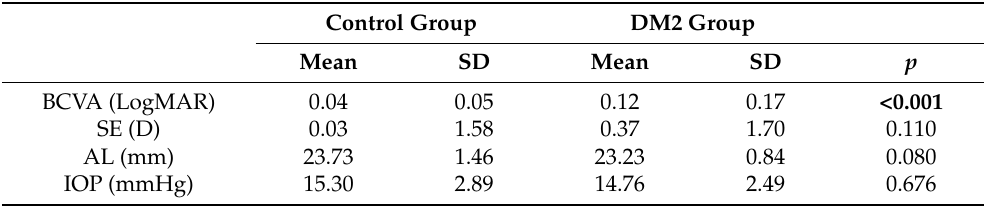
Table 2. Mean, standard deviation (SD), and statistical significance ( p -value) of best corrected visual acuity (BCVA) in the LogMAR scale, spherical equivalent (SE) in diopters (D), axial length (AL) in mm, and intraocular pressure (IOP) in mmHg between the control and type 2 diabetes mellitus (DM2) groups. Differences that reached statistical significance ( p < 0.05) are shown in bold.